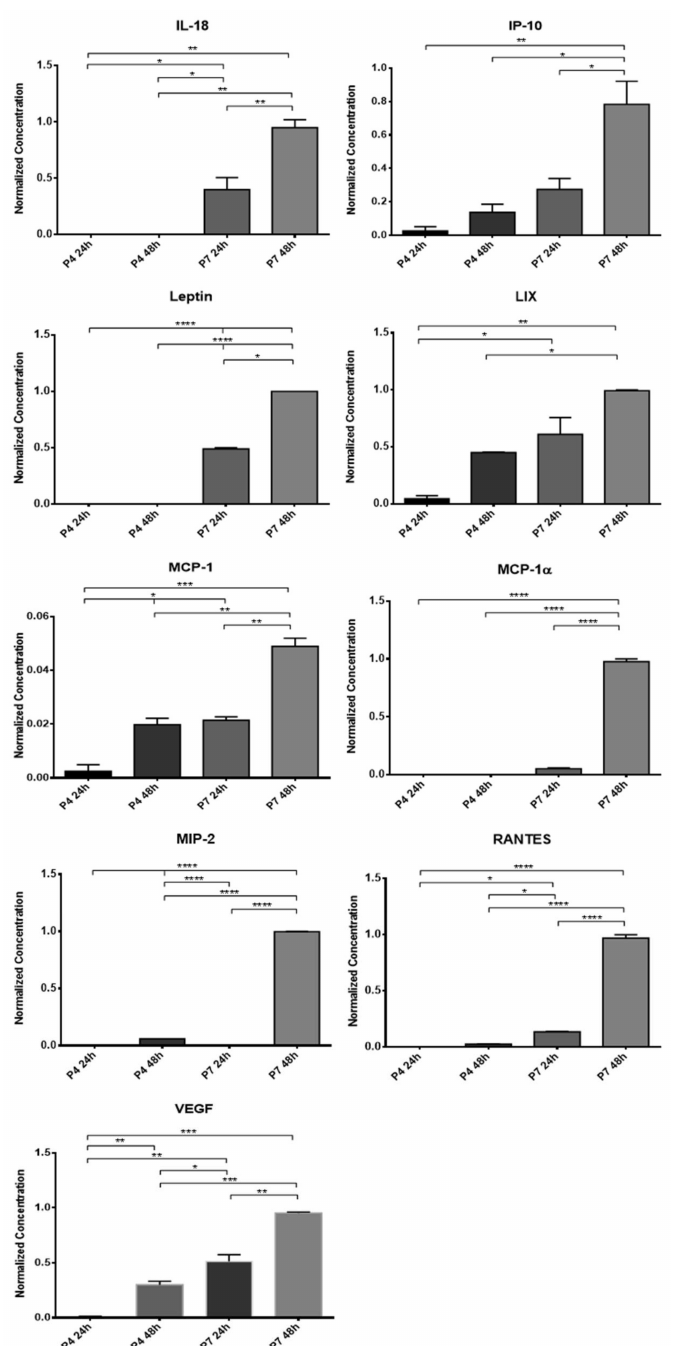
Figure 4. Normalized concentration of each biomarker in the conditioned medium of OECs in P4 and P7 (mean ± SEM). * corresponds to 0.01 ≤ p < 0.05, ** to 0.001 ≤ p < 0.01, *** to 0.0001 ≤ p < 0.001, and **** to p <